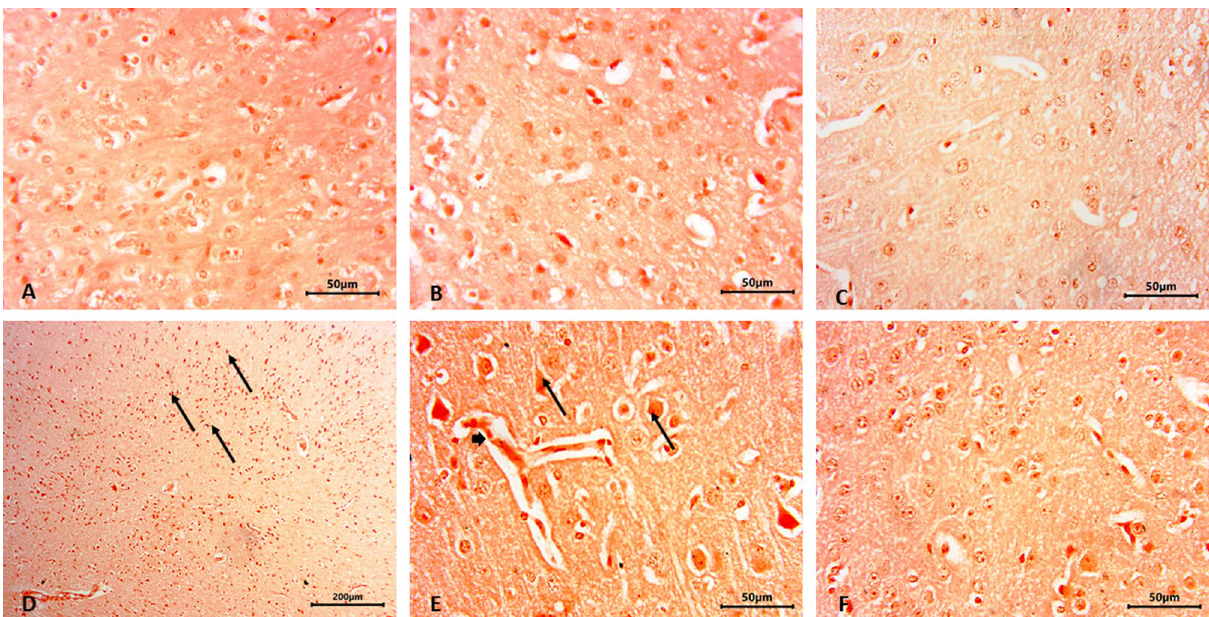
Figure 5. Representative micrograph of the control olive oil group, blank nanoemulsion, and gum Arabic loaded nanoemulsion groups, respectively with no amyloid precipitate with congo red ( A – C ). Amyloid staining labels the vessels (arrow head), the amyloid plaque (arrows) presents in bromobenzene group ( D , E ), mild deposits in bromobenzene + gum Arabic loaded nanoemulsion group ( F ). Congo-red